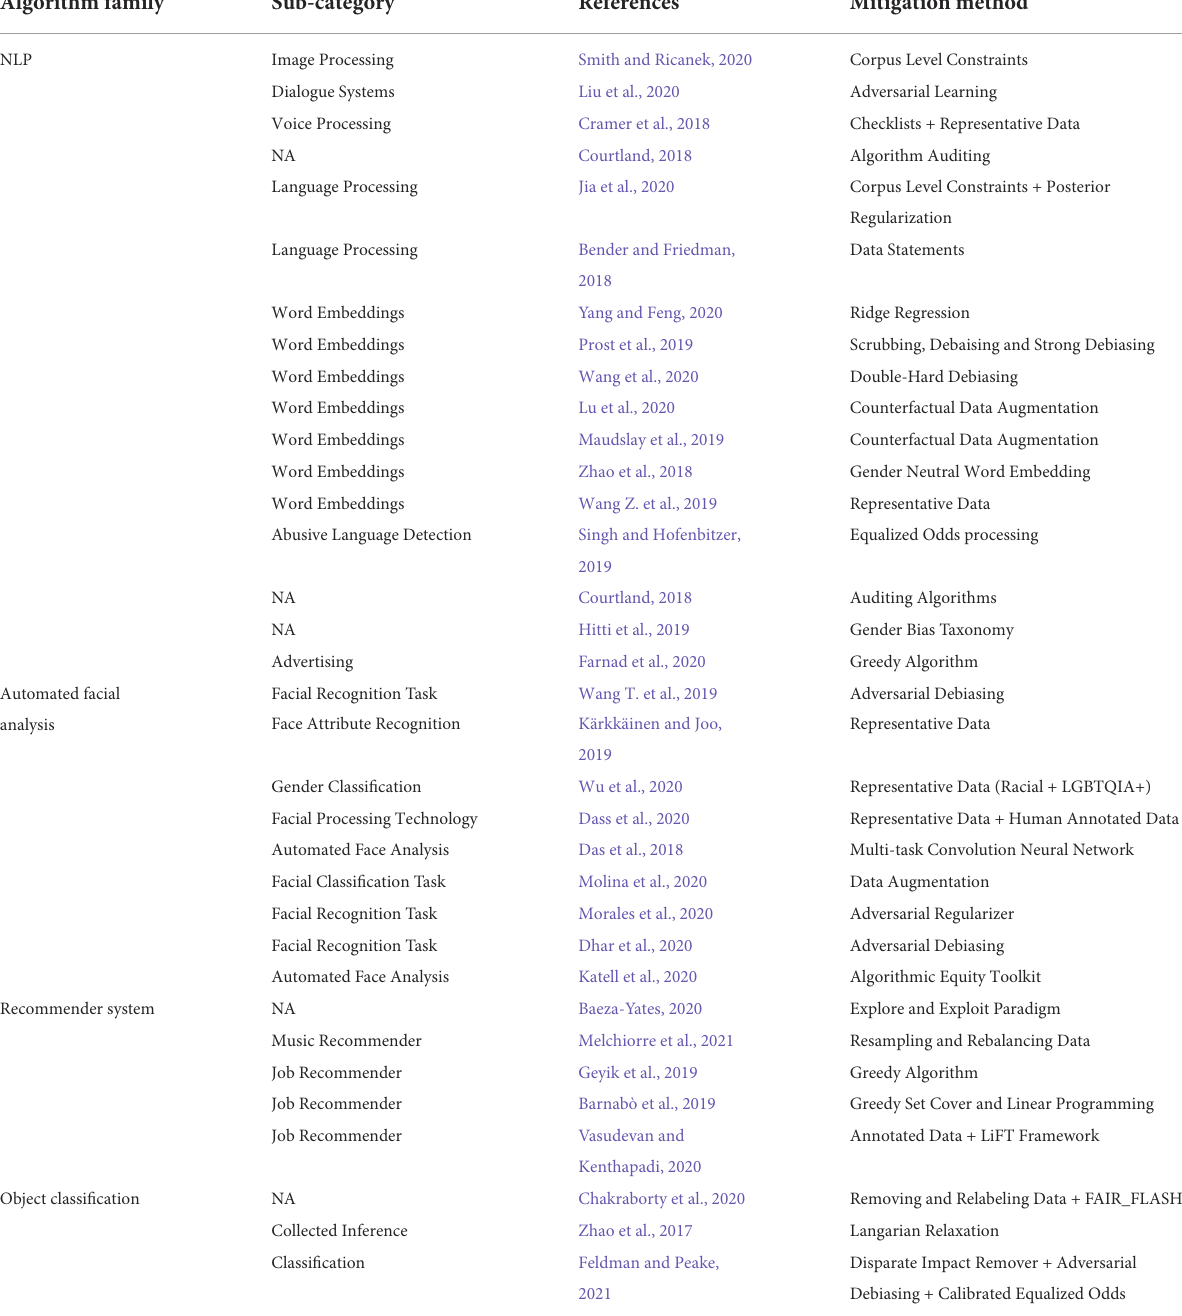
TABLE 2 Different bias mitigation methodologies proposed by the papers reviewed in this